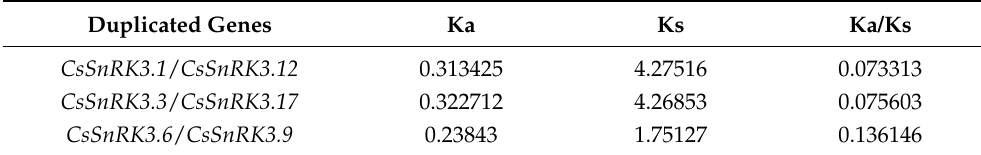
Figure 4. The duplication analysis of CsSnRK family in cucumber. Gray lines indicated all synteny blocks in the cucumber genome, and the orange lines indicated duplicated CsSnRK gene pairs. The chromosome number is indicated on each chromosome. Scale bar marked on the chromosome indicates chromosome lengths (Mb). Chr, Chromosome. Table 2. The KaKs values of the paired duplicated CsSnRK